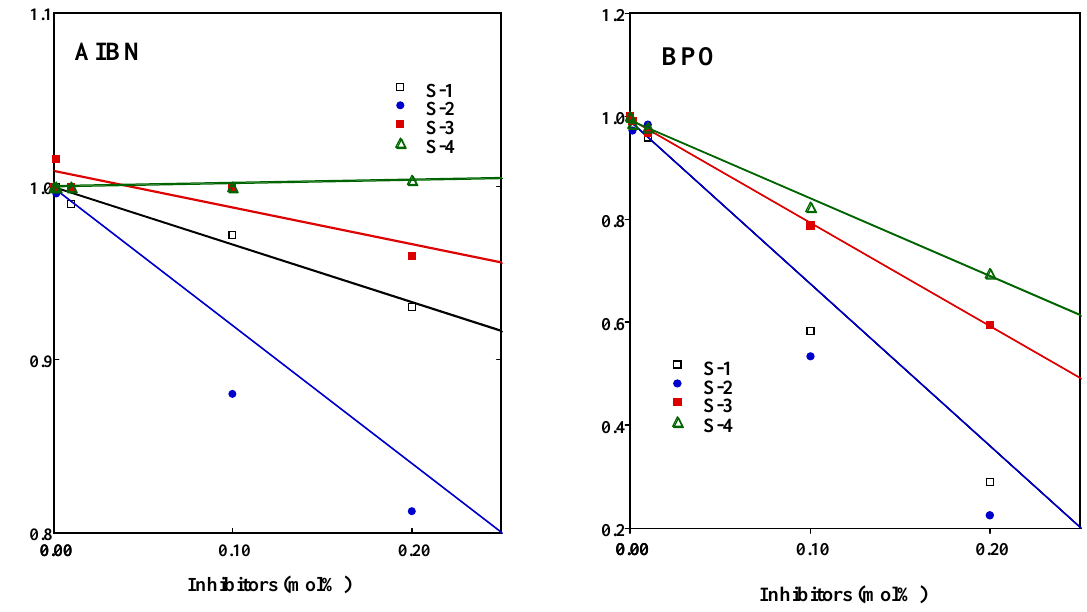
/Rp vs the concentration for ISO-S-1 , 2, 3 , and 4 inh con